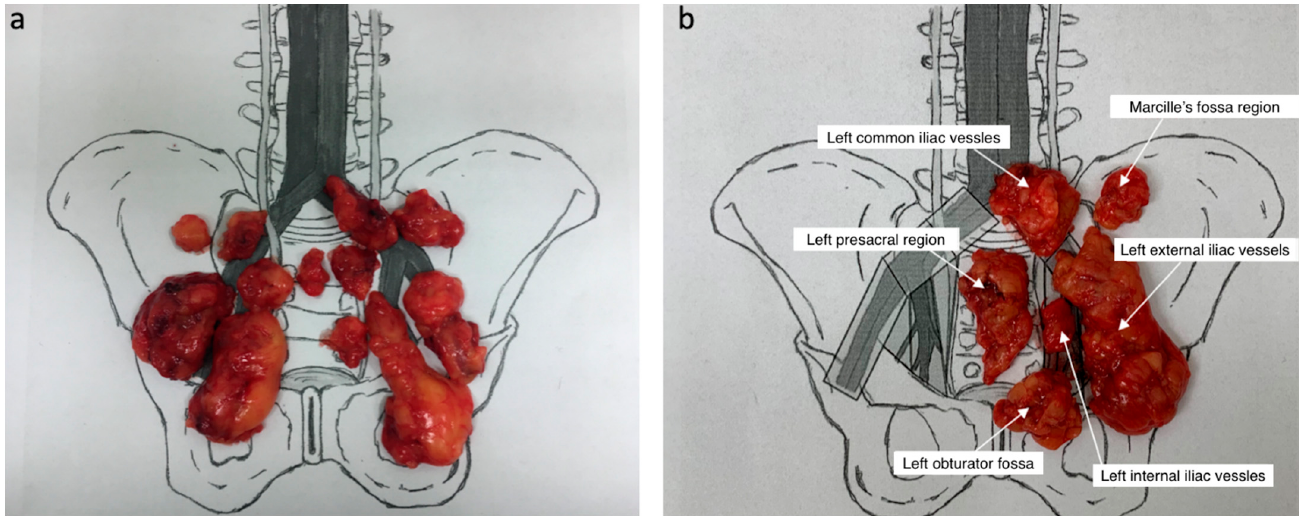
Figure 2. Sentinel lymph node specimens mapped on the scheme ( a ) and grouped into specific lymph node regions ( b ).